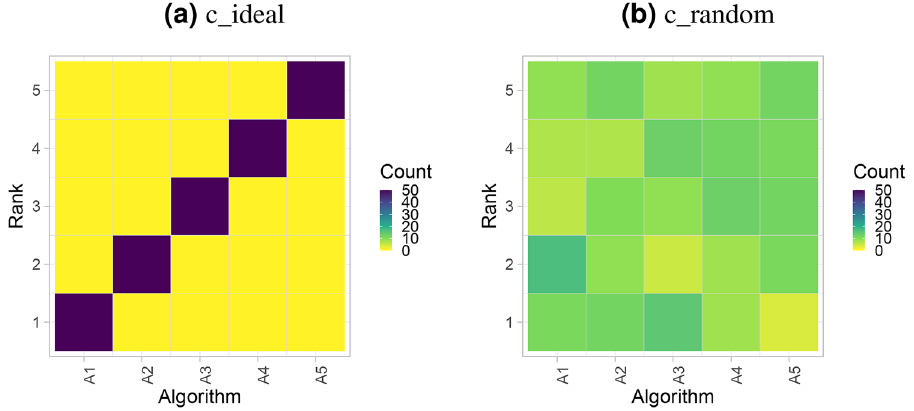
Figure 3. Ranking heatmaps for visualizing assessment data. Each cell (cid:31) i , A j (cid:30) shows the absolute frequency of test cases in which algorithm A j achieved rank i .